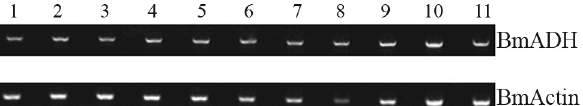
Figure 1 - Amino acid sequence alignment of deduced BmADH, Homo sapiens 15-hydroxyprostaglandin dehydrogenase (Hs15HPGDH), D. lebanonensis alcohol dehydrogenase (DlADH), and D. melanogaster al- cohol dehydrogenase (DmADH). are NP_001037610.1, P15428, P10807 and P00334, respectively. * indicates identical residues; * indicates enzyme active-center residues; : indicates conserved residues; . indicates semi-conserved residues.